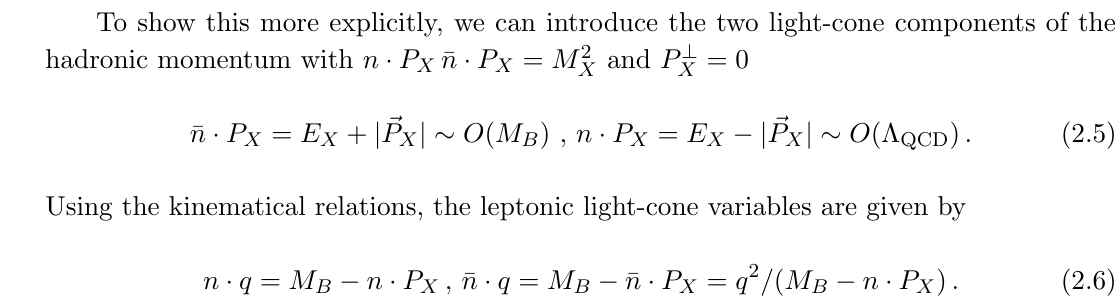
Figure 2 . The scaling of the momentum components of the hadronic system P + P (cid:0) = (cid:22) n P X (left) and the lepton system q + = n X (cid:1) each for three values of the hadronic invariant